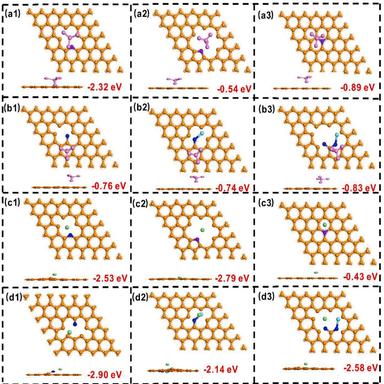
The top-view (x-y plane) and side-view (y-z plane) of ClO4 − and Na-ion adsorbed on functionalized carbon with a1 and c1) pyridinic-N, a2, and c2) pyrrolic-N, a3, and c3) graphitic-N, b1, and d1) carbonyl group, b2, and d2) hydroxylic group and b3 and d3) carboxyl group.